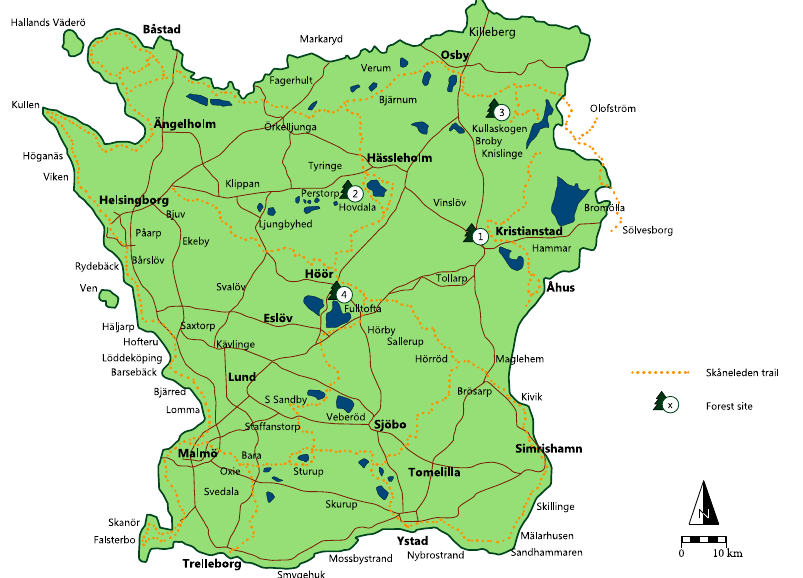
Figure 2. Map of the county of Skåne, with the hiking trail Skåneleden in orange; Women´s Clinic in Kristianstad in City of Kristianstad ① . The three forest sites used of the intervention; Hovdala ② , Kullaskogen ③ and Fulltofta ④ . [Map: based on Lantmäteriet by Ellinor Arvidsson: 2023].